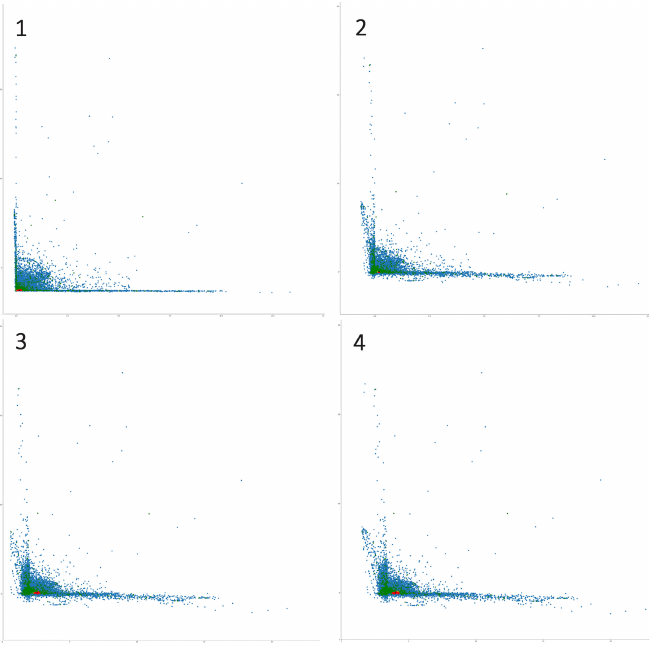
Figure 4. The examples of clustering using the neighbor-based minimization method obtained on four consequent encoder forward passes. Green color points are the ID s, blue color points are the UD